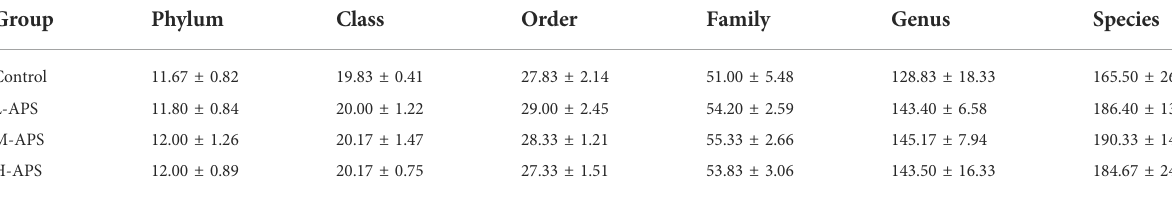
TABLE 2 Average taxonomic abundance of rat micro fl ora in each group.